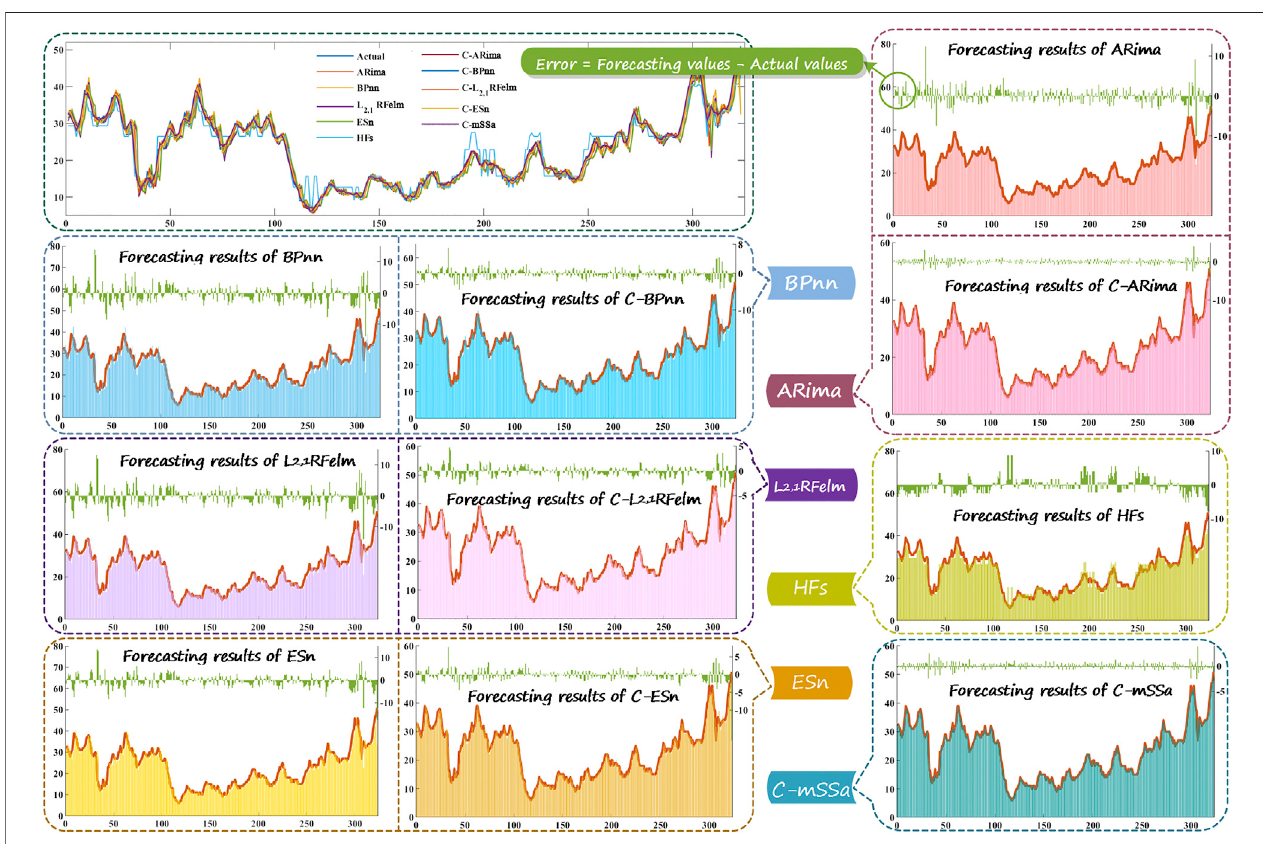
FIGURE 2 | The forecasting results of the different models, where “ C- ” represents the forecasting models combined with cEEMDan.